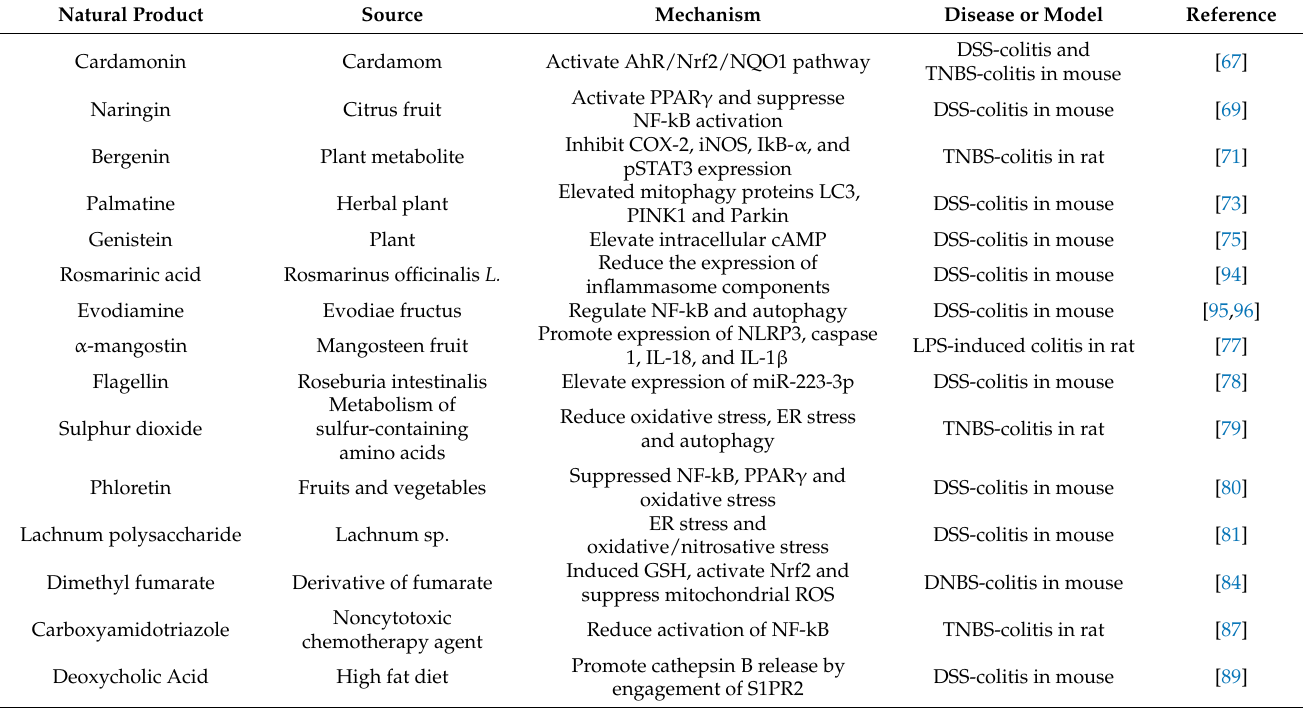
Table 2. Preventing colitis in animal models of colitis or patients with IBD by targeting inflammasomes. Natural